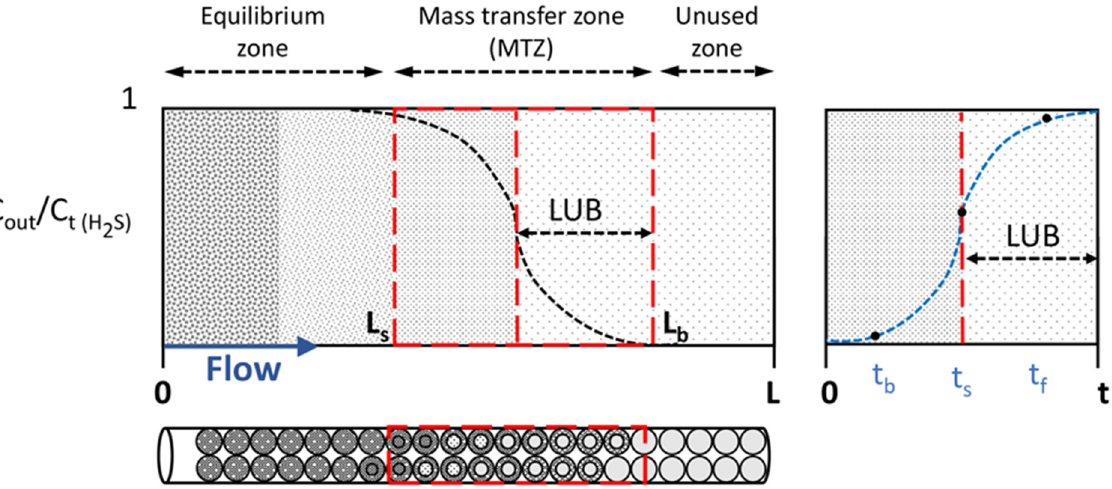
Figure 2. Wavefront of the mass-transfer breakthrough curve through an adsorption bed of length L using a starting H 2 S concentration ( C H ). L s and L b correspond to the saturated and break- 2 S through length, respectively, while t b , t s , and t e are associated with breakthrough, stoichiometric, and equilibrium time,